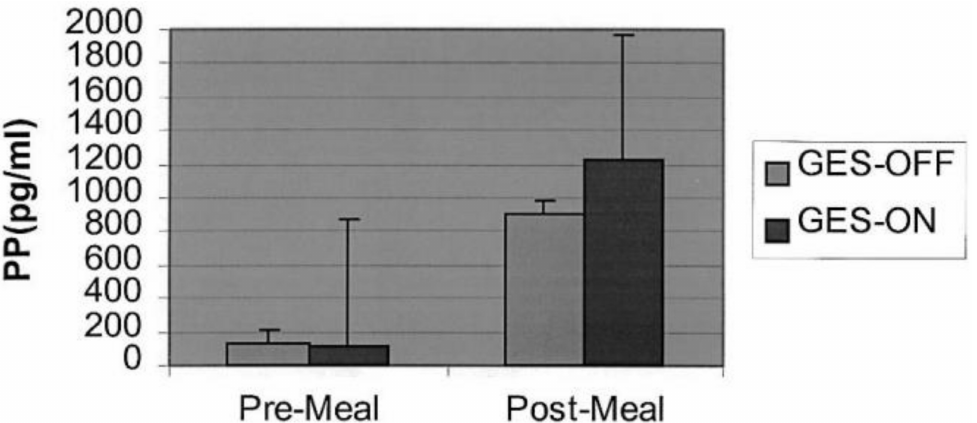
Figure 6. Improvement in pancreatic function in a controlled, randomized and blinded study of GES. Serum pancreatic polypeptide (PP) level in 7 patients with gastroparesis in relation to meal and gastric electrical stimulation (GES-OFF and GES-ON). PP was similar at lowest baseline level between GES-OFF and GES-ON ( p > 0.3). Highest PP level after the meal was greater with GES-ON than GES-OFF ( p = 0.08)